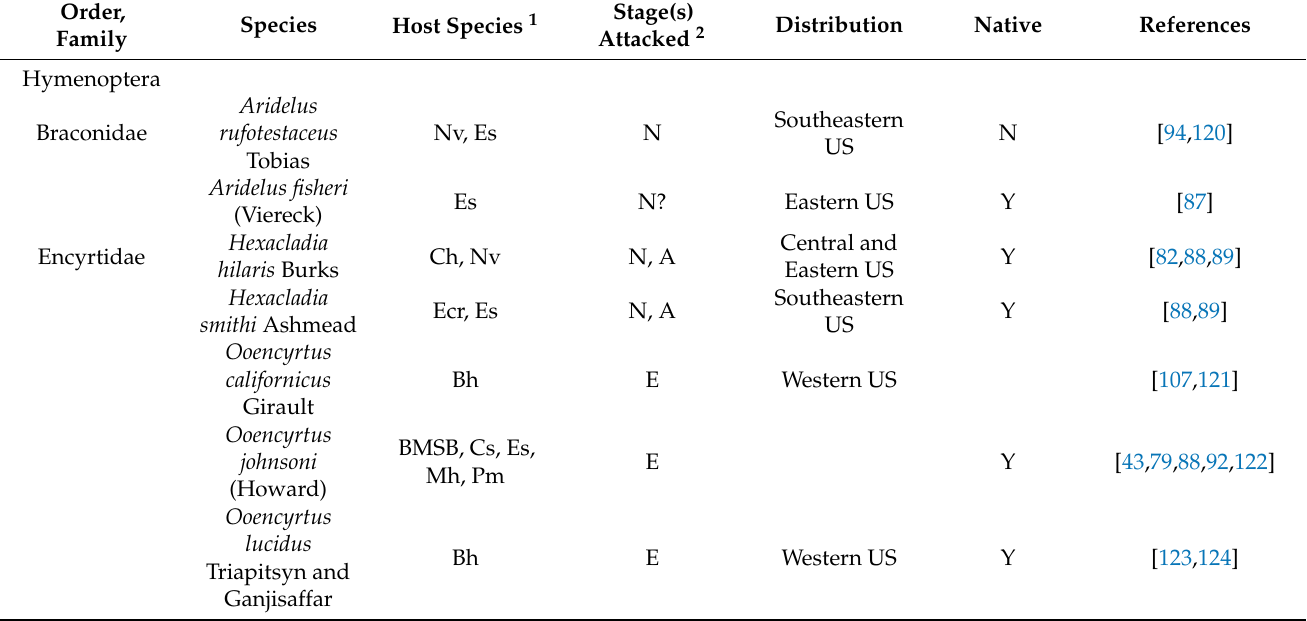
Table 1. Parasitoids of stink bugs reported in North America, with hosts, stages attacked, and coarse